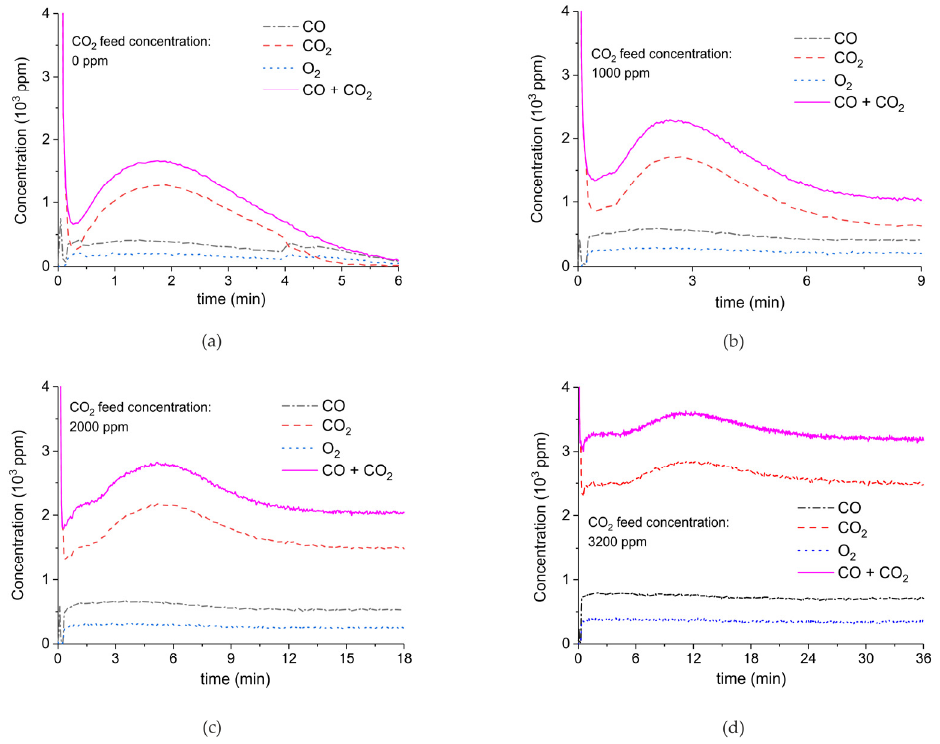
Figure 9. CO + CO 2 (solid line), CO 2 (dashed line), CO (dash-dotted line), and O 2 concentrations monitored by mass spectrometry during CaCO 3 decomposition in different CO 2 feed concentrations in Ar and different plasma power. The amount of CaO is 6 mg, temperature is 630 °C, and the flow rate is 90 mL min − 1 . The fed CO 2 concentration is 0 ppm ( a ), 1000 ppm ( b ), 2000 ppm ( c ), and 3200 ppm ( d ). The plasma power is 1.5 W (a), 1.3 W (b), 1.3 W (c), and 1.5 W (d).